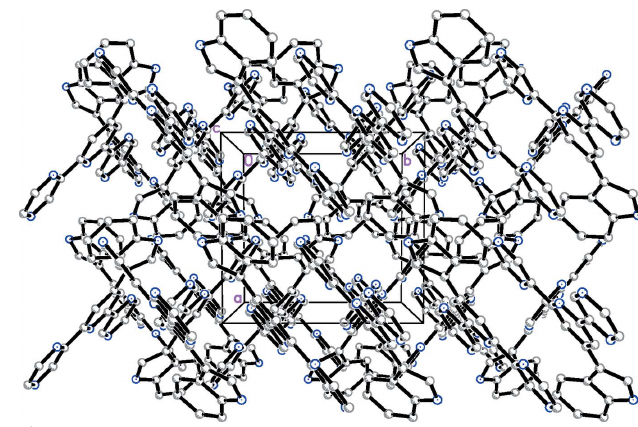
Figure 4 The packing of the title compound.